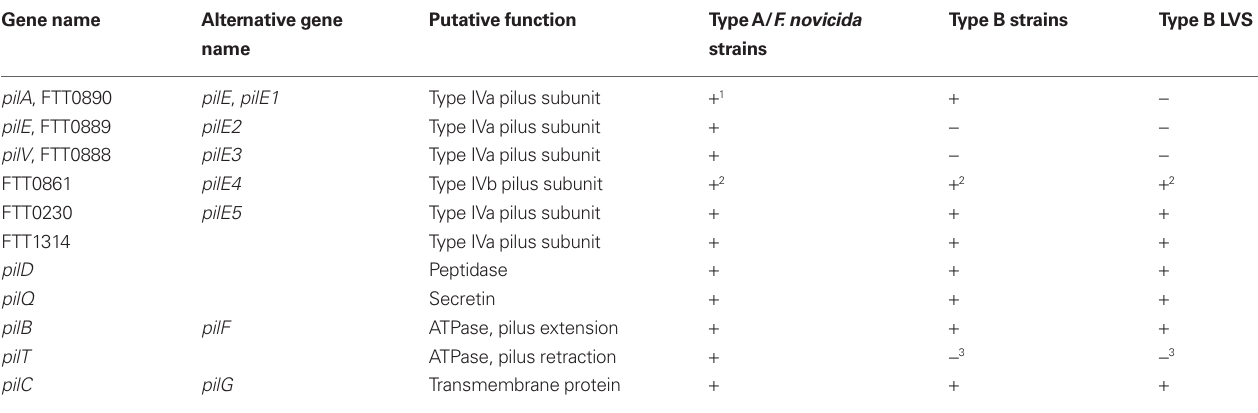
Table 1 | Nomenclature and presence of functional Tfp genes in different